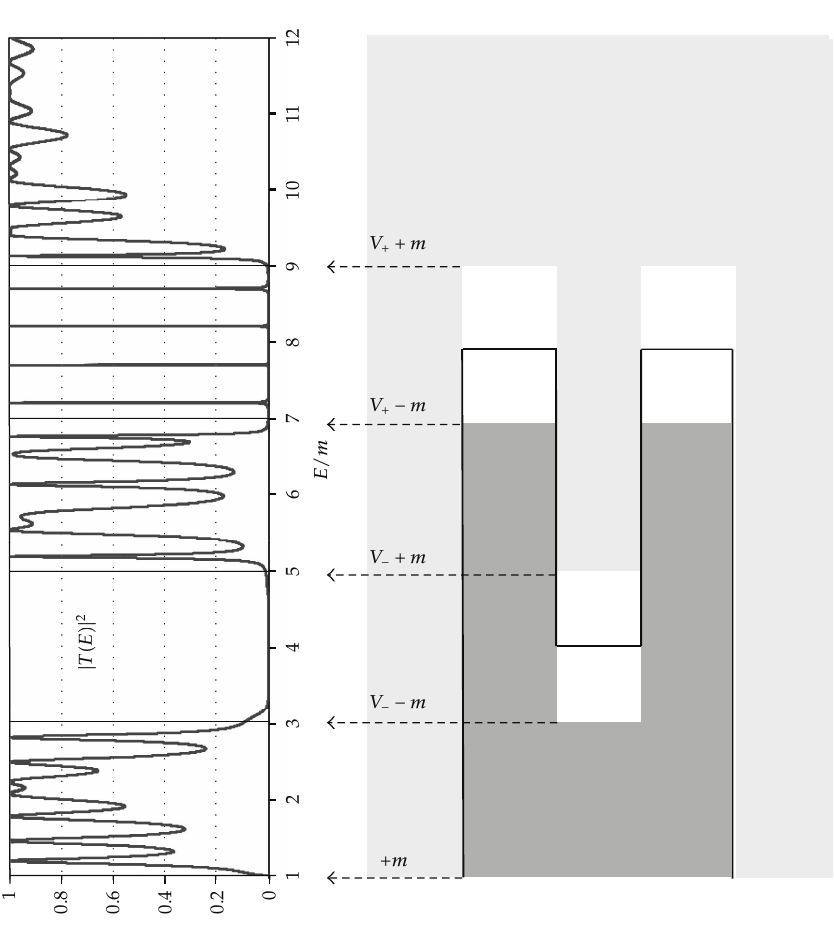
Figure 3: We combine Figures 1 and 2 together in such a way that Figure 2 is turned 90 degrees such that the energy axis of Figures 1 and 2 coincide. In this way, one can clearly see how the di ff erent transmission regions correspond to the di ff erent potential